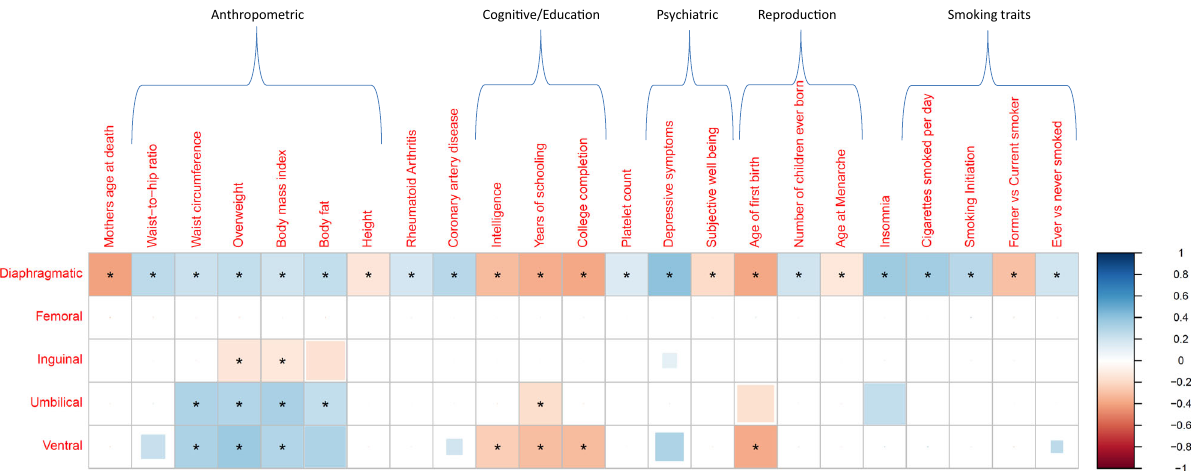
Fig. 6 Genetic correlation analysis for the fi ve forms of hernia. Pairwise genetic correlations estimated via bivariate LD score regression for 245 traits. Only correlations that were signi fi cant after correction for multiple testing in at least one form of hernia are shown ( P < 2.04 × 10 − 4 , indicated by an asterisk). Positive genetic correlations are shown in blue, negative ones in red for all combinations where P < 0.05, with the size of the colored squares indicating the signi fi cance level (truncated at P < 2.04 × 10 − 4